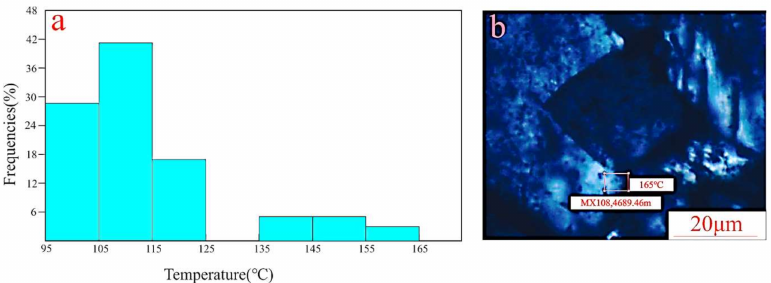
Figure 7. Homogenization temperature of fluid inclusion. ( a ) Distribution histogram of the homogeniza- tiontemperatureoffluidinclusionwithindolomites; ( b )imageoffluidinclusionsinMX108well 4689.46